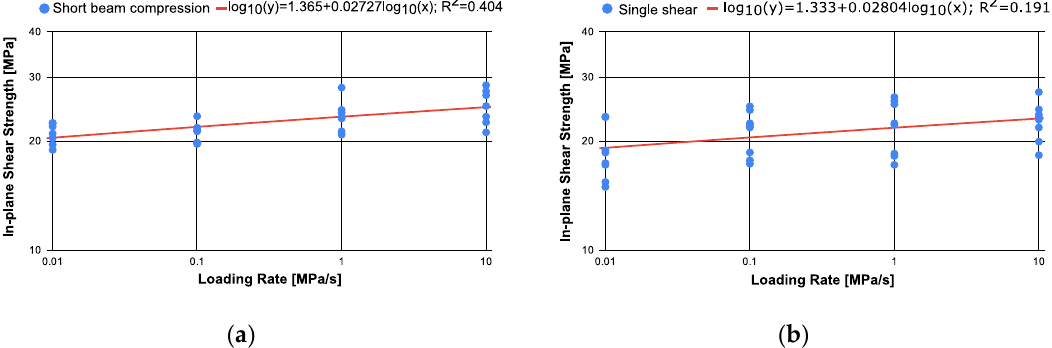
Figure 12. In-plane shear strength versus loading rate: ( a ) short-beam compression test; ( b ) single- shear test.